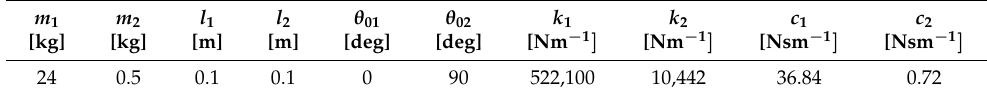
Table 1. First guess values of the design